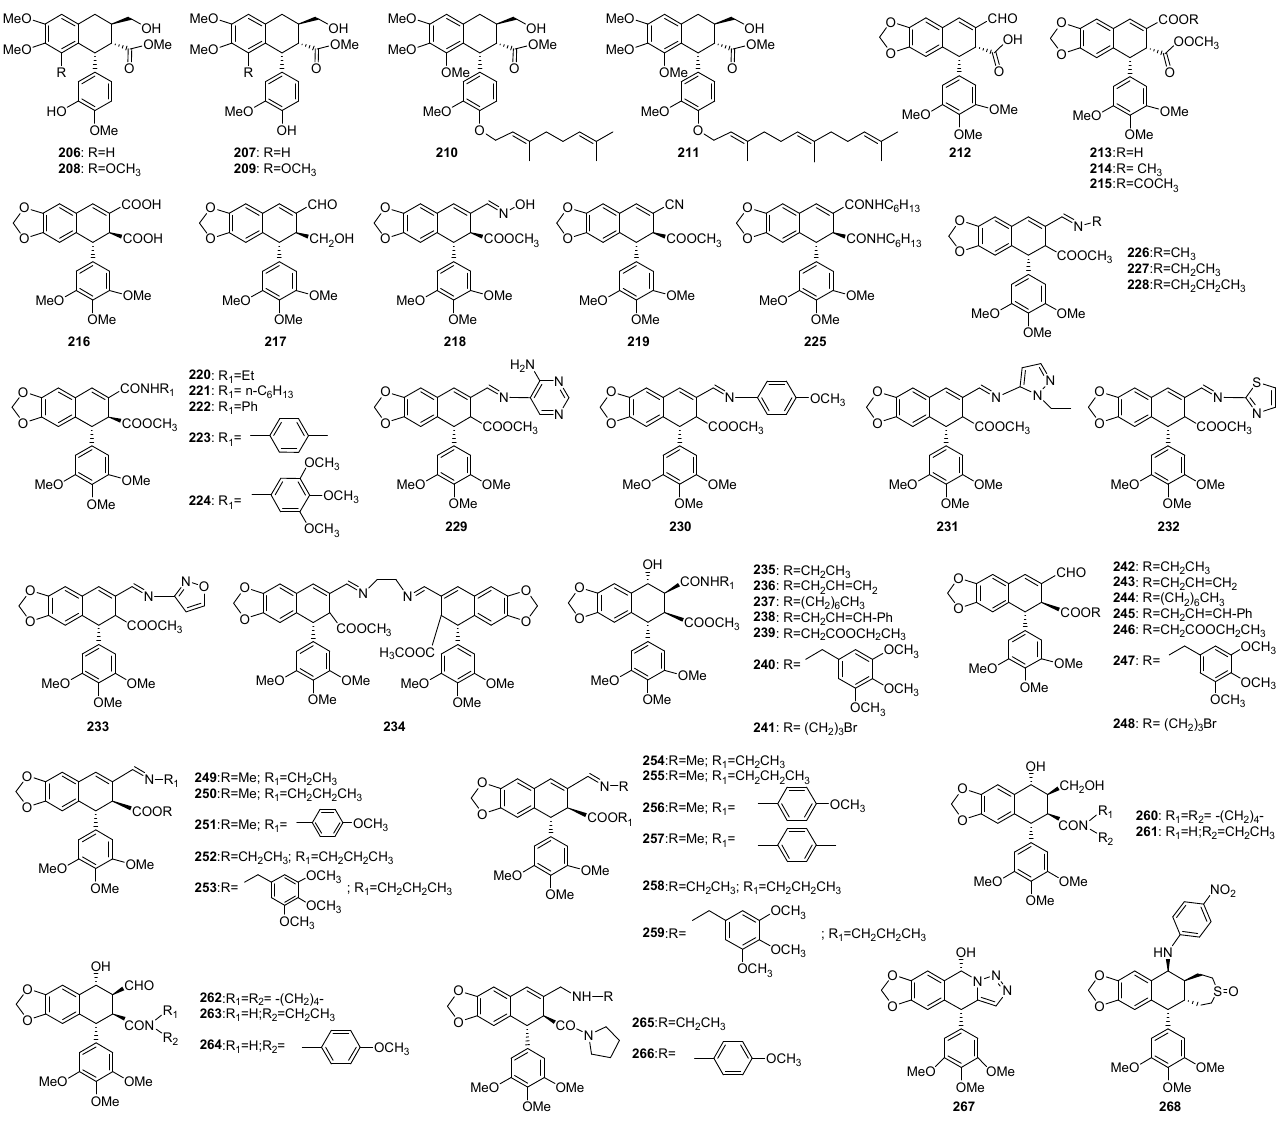
Figure 7. D-ring modified podophyllotoxins.